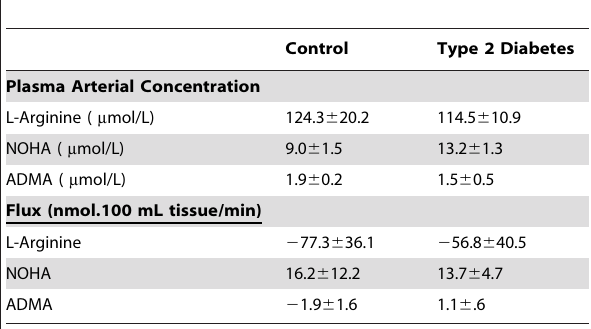
Table 2. Biochemical characteristics of the study cohort.